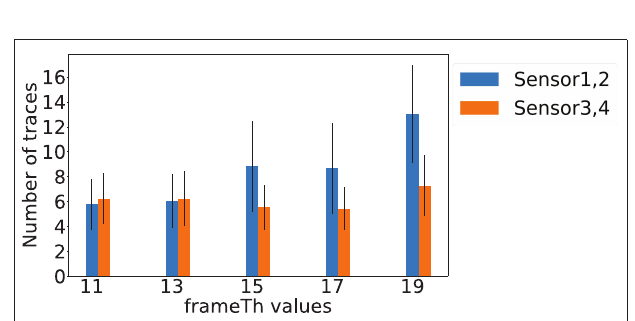
FIGURE 14 | Number of traces sampled when frameTh vary. The x -axis is the frameTh value and the y -axis is the number of traces sampled till four footfall events that met constraints being extracted.